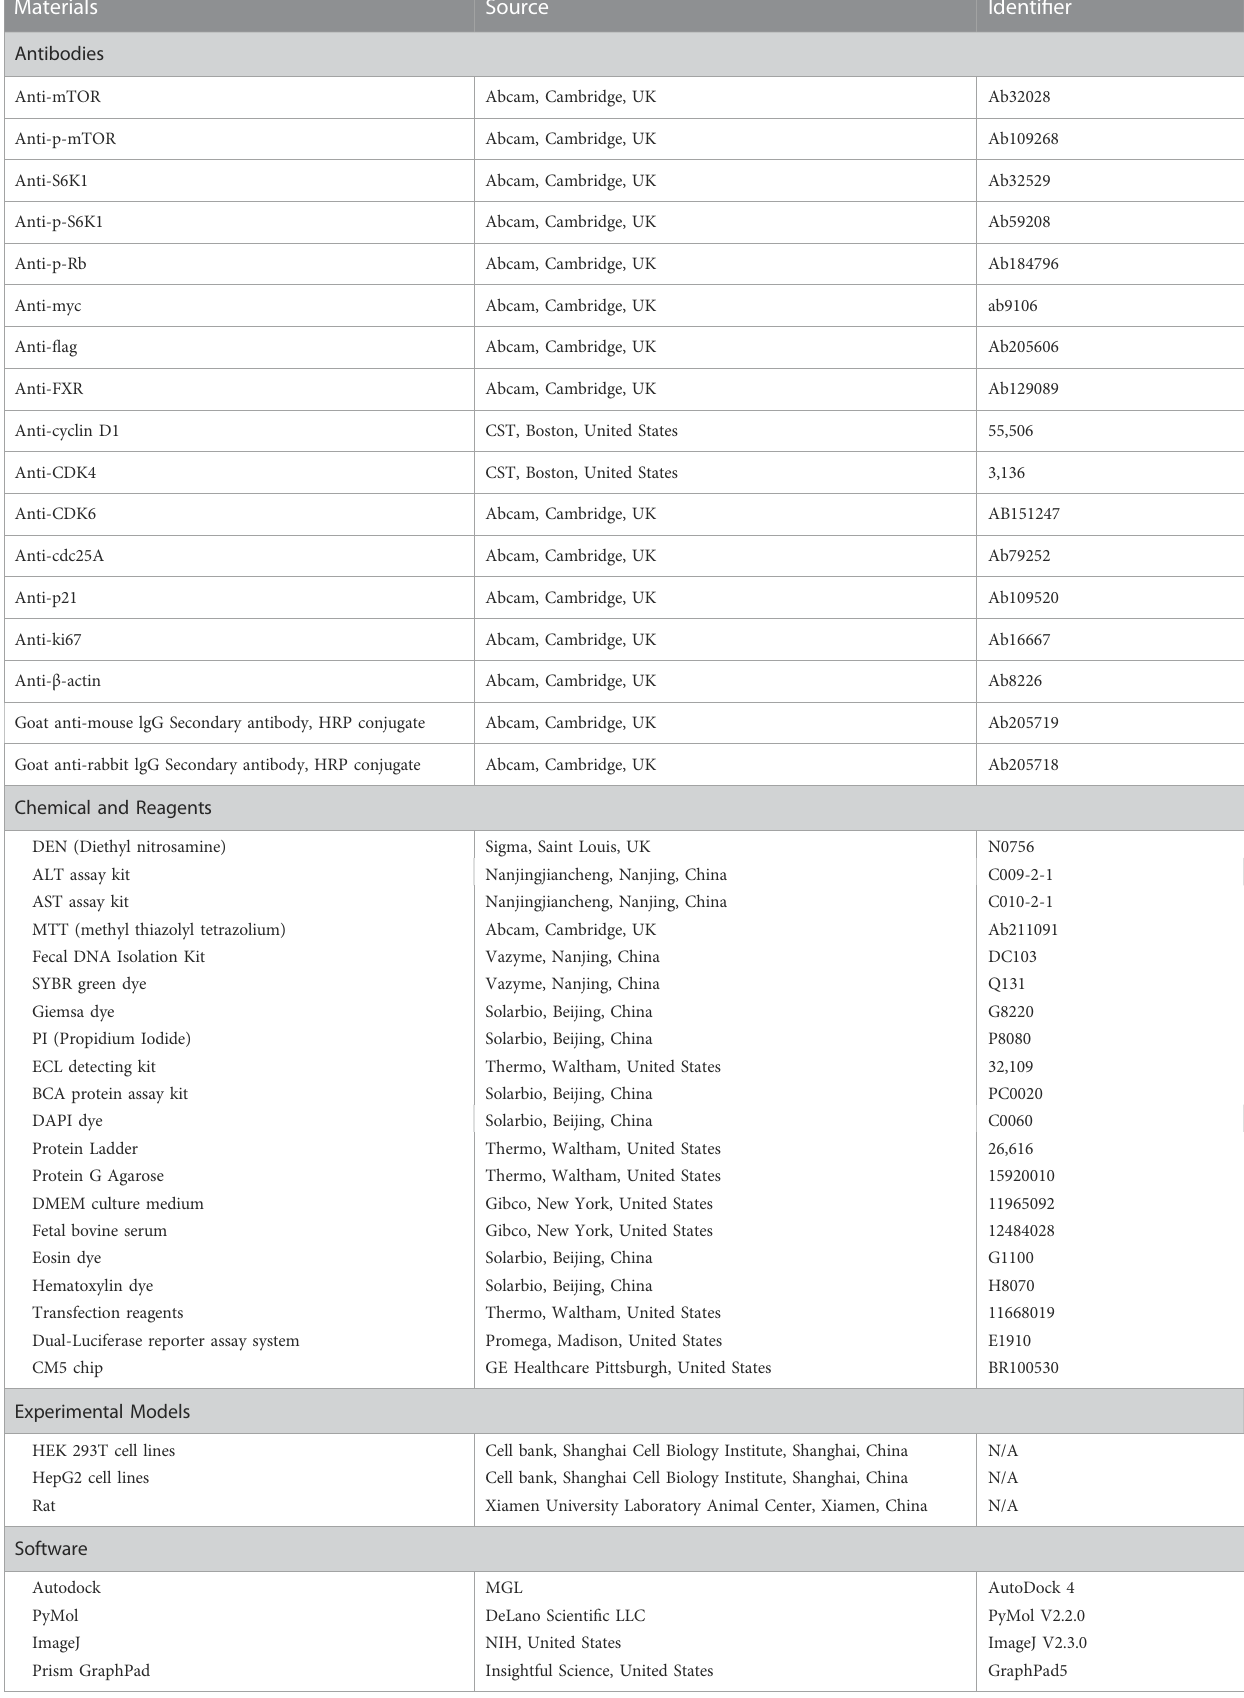
TABLE 1 The materials used in this